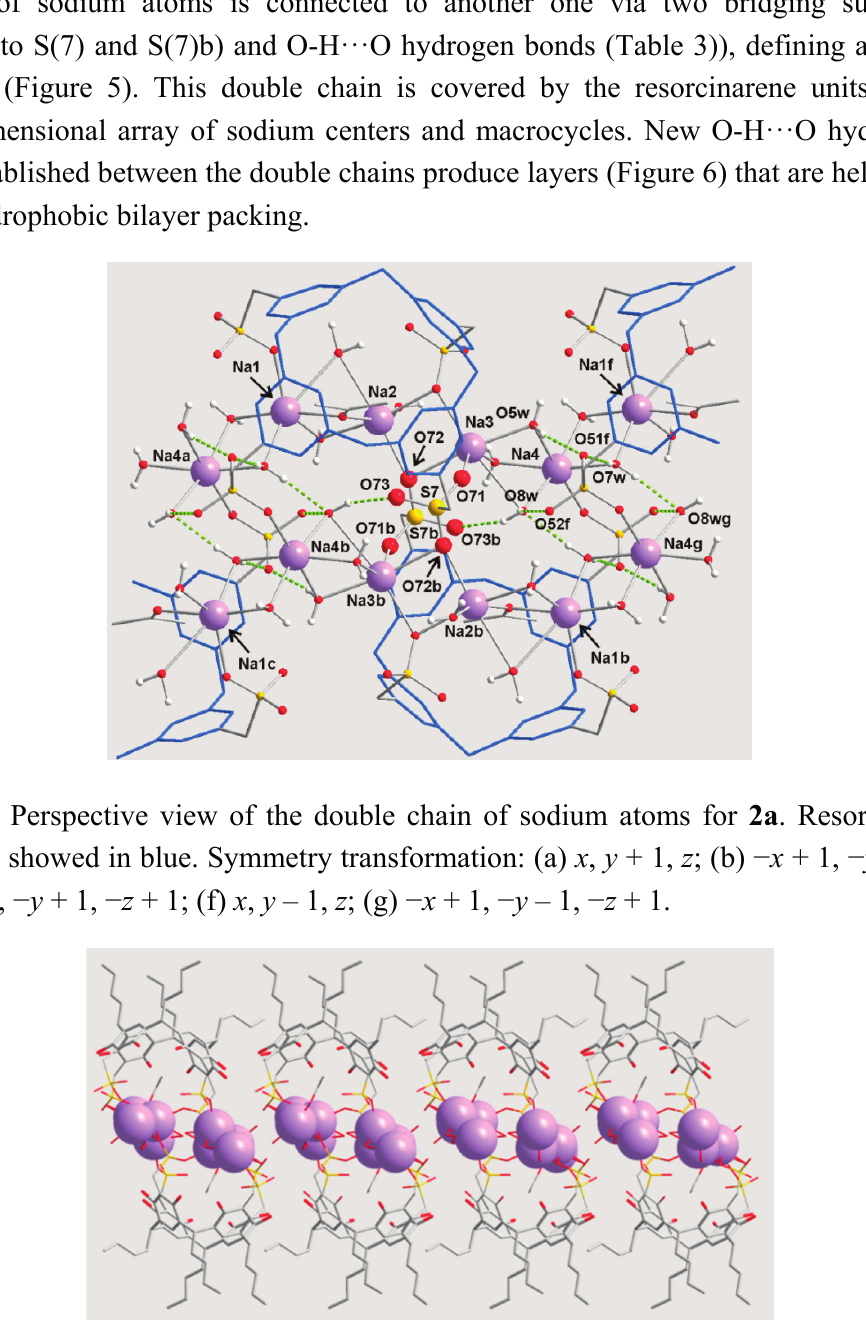
Figure 6. Perspective view of a layer for 2a . Sodium atoms are showed as purple